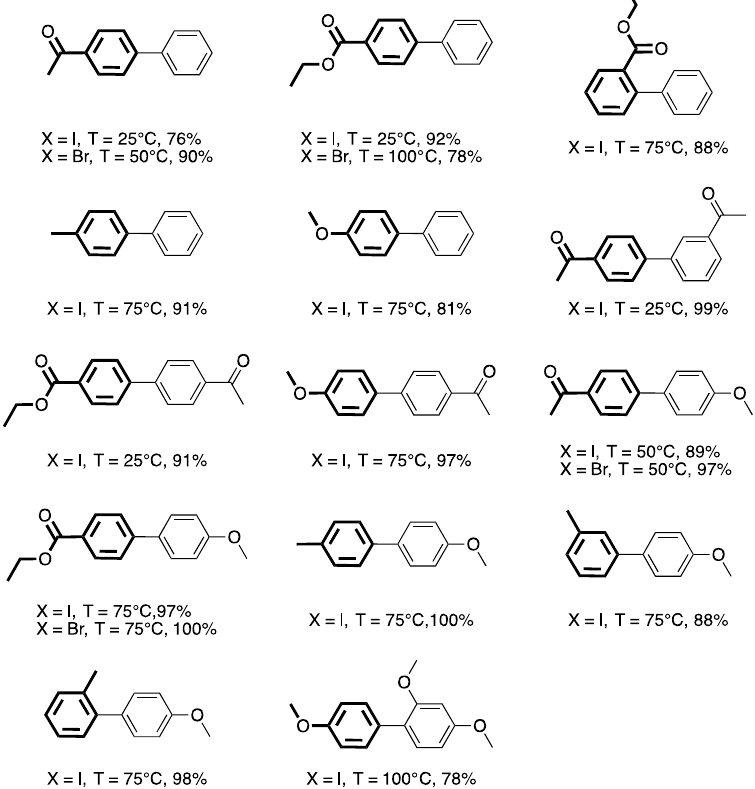
Figure 3. Substrate scope of continuous flow Suzuki–Miyaura cross-coupling sequence in a flow system using H-Cube ®